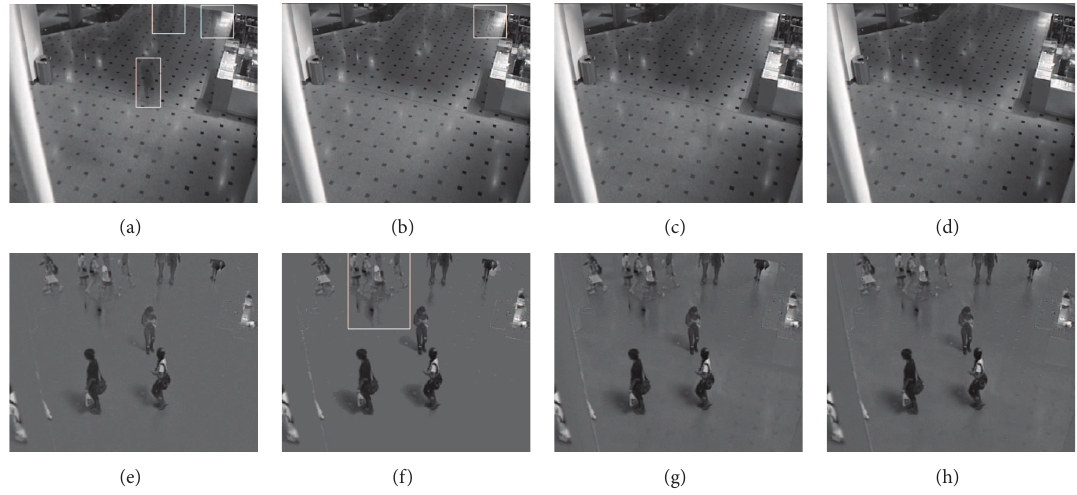
Figure 4: Shopping mall: (a)–(d) background and (e)–(h) foreground from IALM, GoDec, NSMP, and